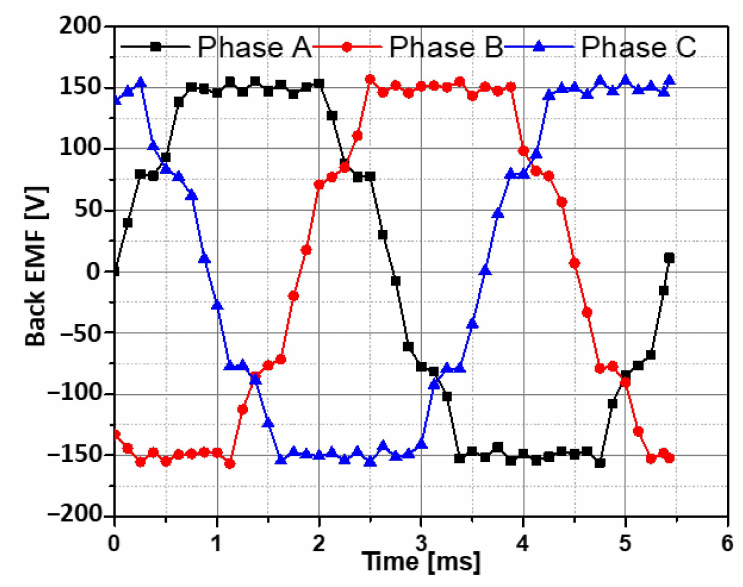
Figure 4. No load back EMF at rated